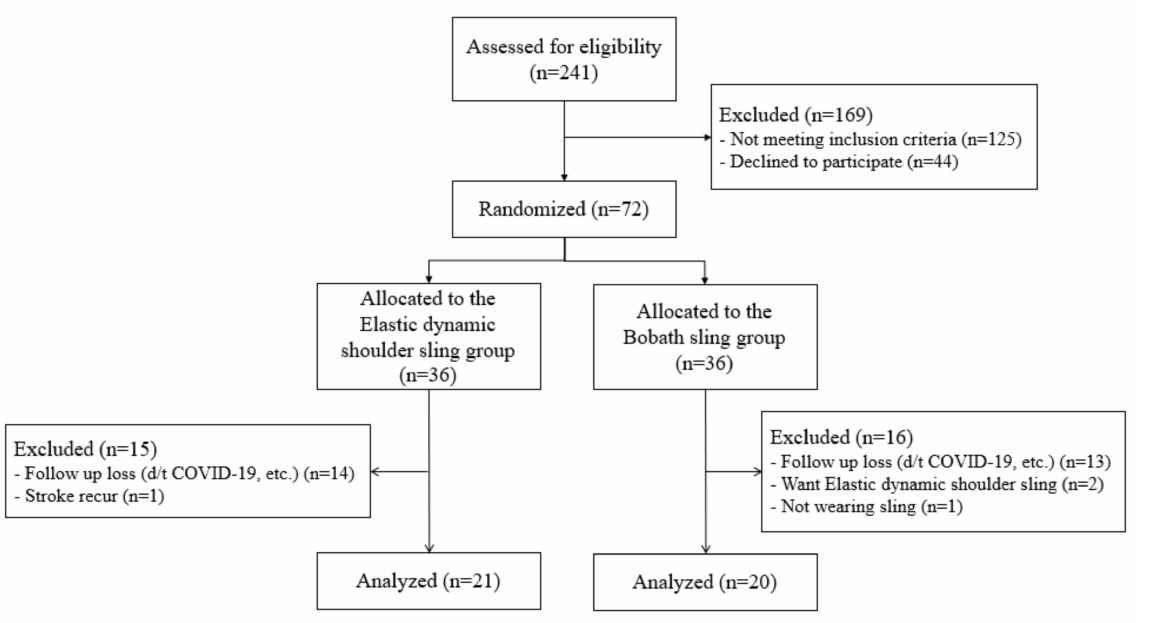
Figure 5. Flow chart of study participants